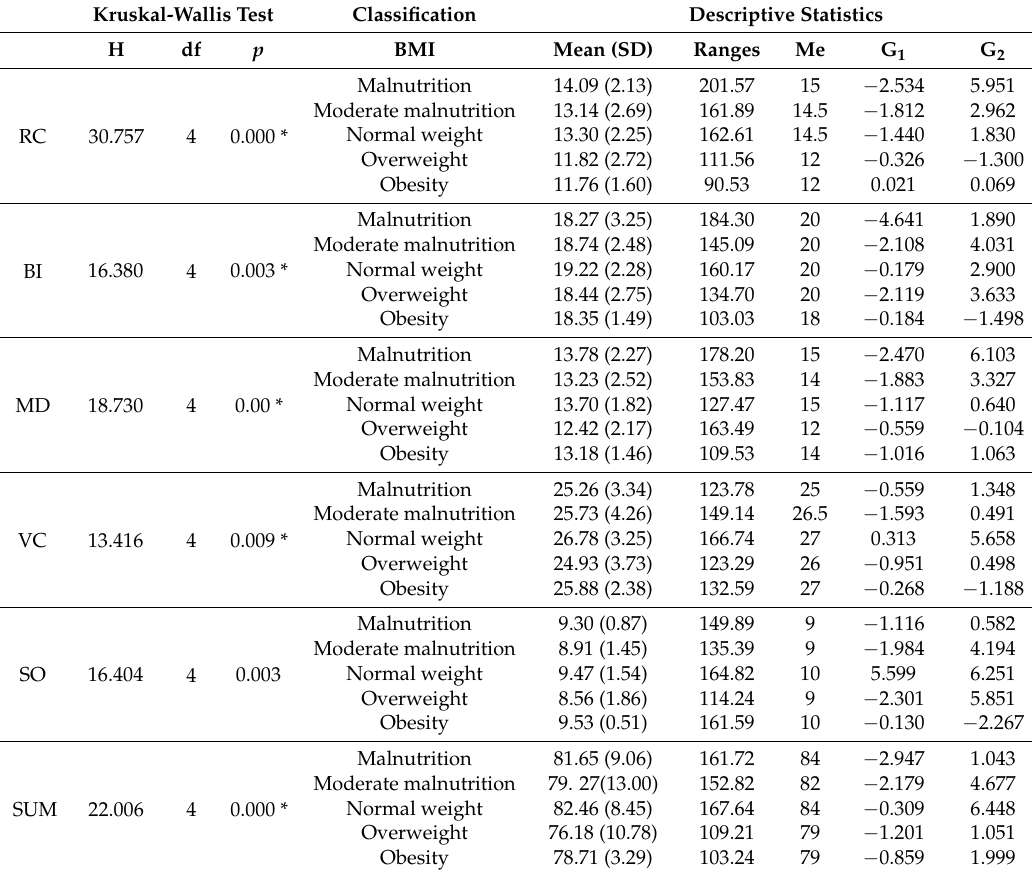
Table 5. Kruskal-Wallis test and descriptive statistics for perceptual skills according to BMI for the sample of